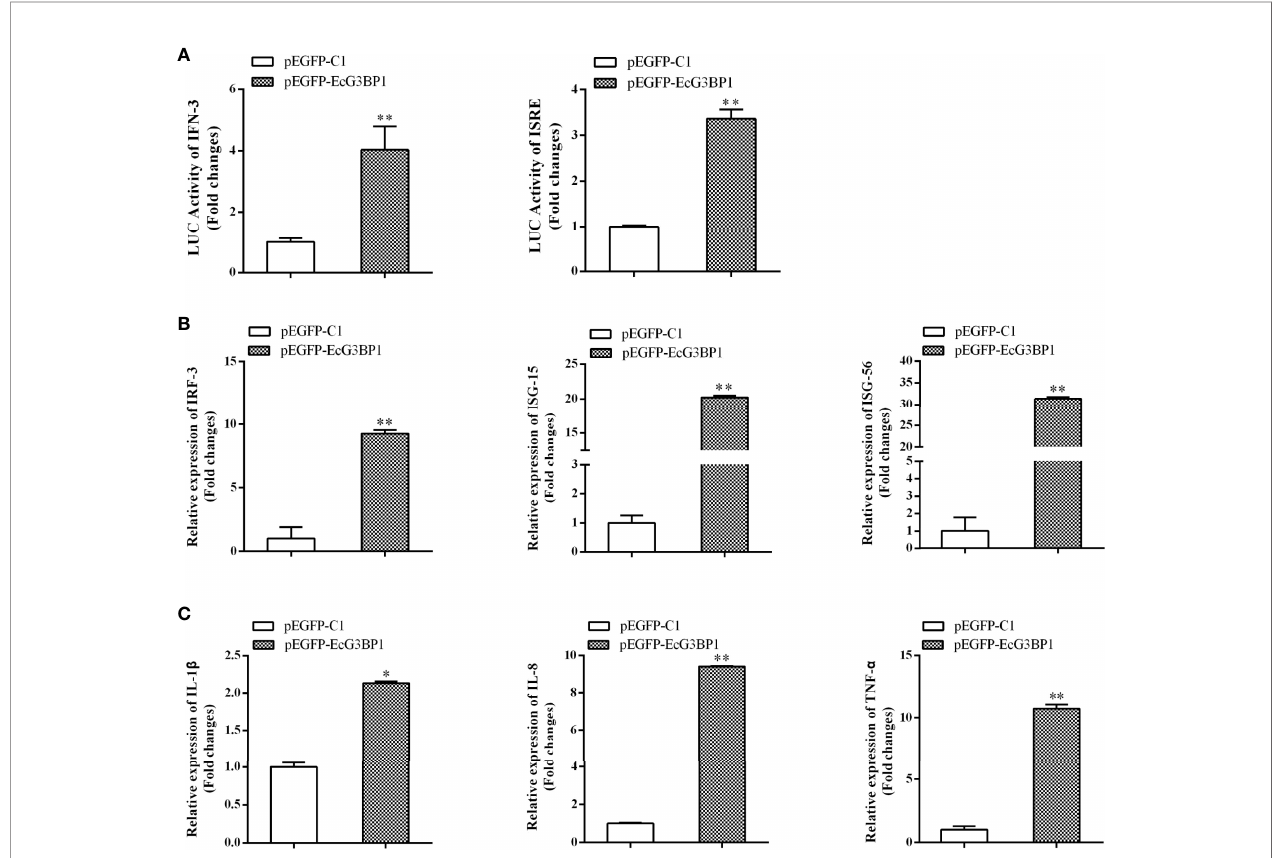
FIGURE 7 | Overexpression of G3BP1 up-regulated interferon immune response and pro-in fl ammatory cytokines. (A) Effects of overexpression of EcG3BP1 on IFN- 3 and ISRE promoter activities. (B) and (C) Overexpression of G3BP1 increased the expression of interferon related cytokines and pro-in fl ammatory factors. pEGFP- EcG3BP1 was transfected into GS cells, which were collected at 36 h to detect the expression of interferon related cytokines (IRF3, ISG15, and ISG56) and pro- in fl ammatory factors (IL-1 b , IL-8, and TNF- a ) by qRT-PCR (* p < 0.05, ** p <